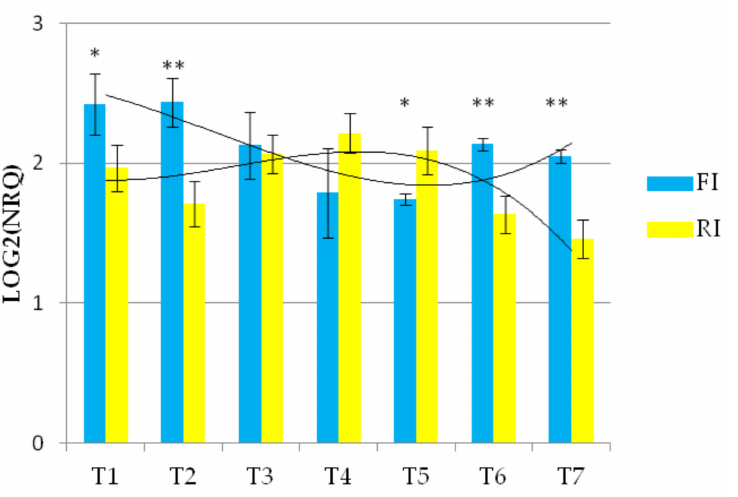
Figure 4. The expression profile of Wdhn13 gene transcript of AEL under FI and RI conditions. A third-order polynomial trendline was added to highlight the opposite concavities; ** p < 0.01, * p <